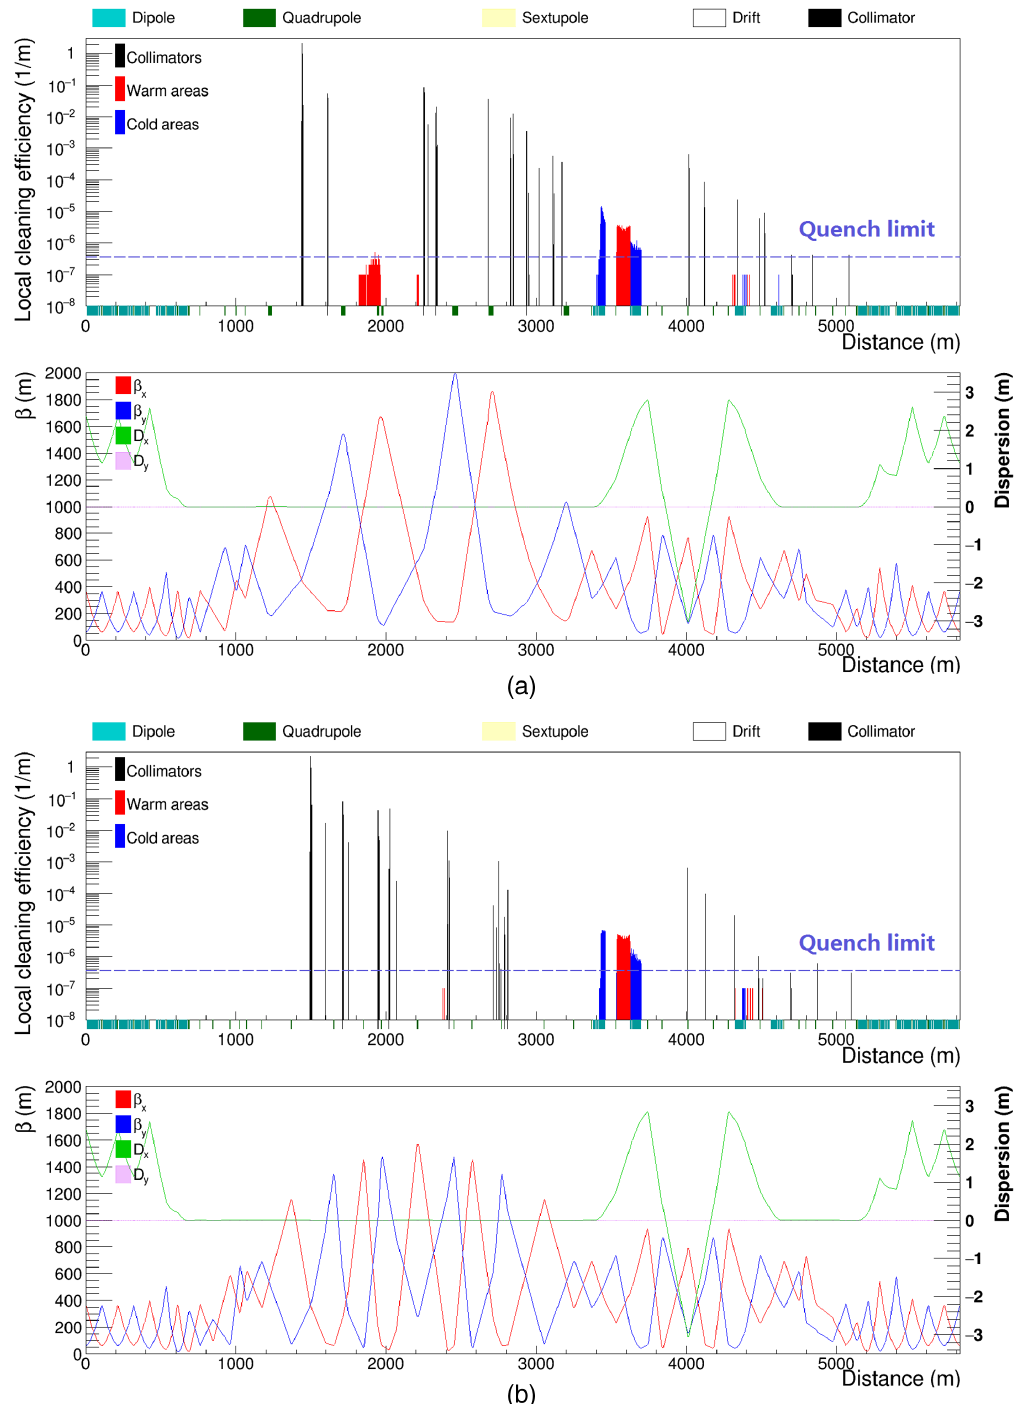
FIG. 7. Proton loss maps in the collimation insertion with an initial horizontal halo distribution, using lattice scheme I (a) and II